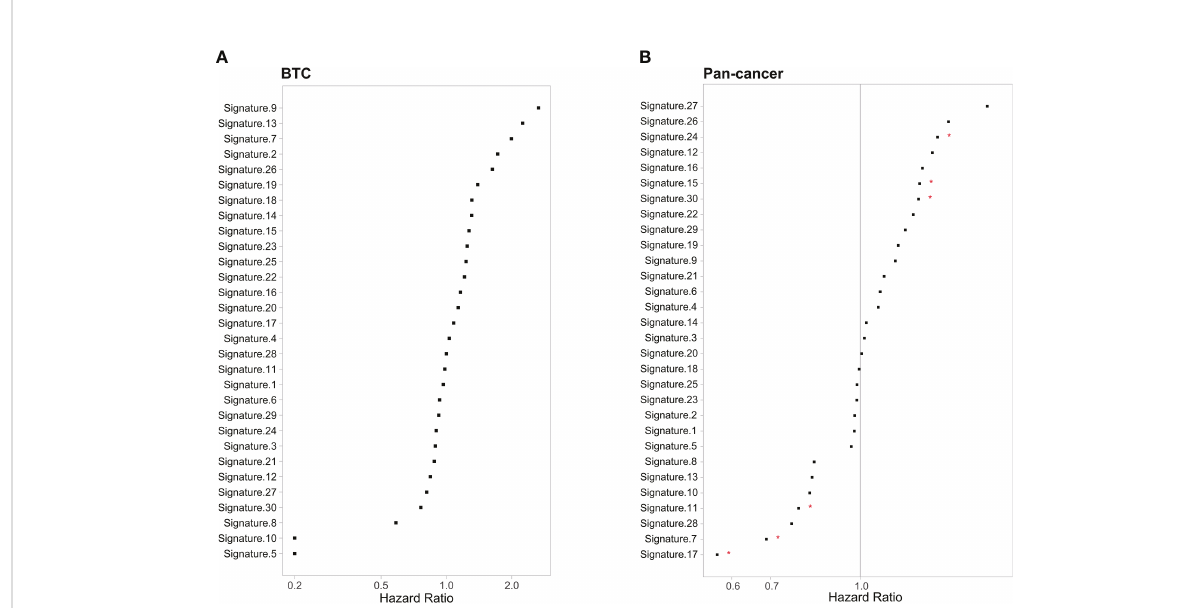
FIGURE 10 Correlation between the 30 COSMIC mutational signature and survival in (A) MSKCC BTC patients and (B) MSKCC pan-cancer patients. * p < 0.05. COSMIC, Catalogue of Somatic Mutations in Cancer; MSKCC, Memorial Sloan Kettering Cancer Center; BTC, biliary tract